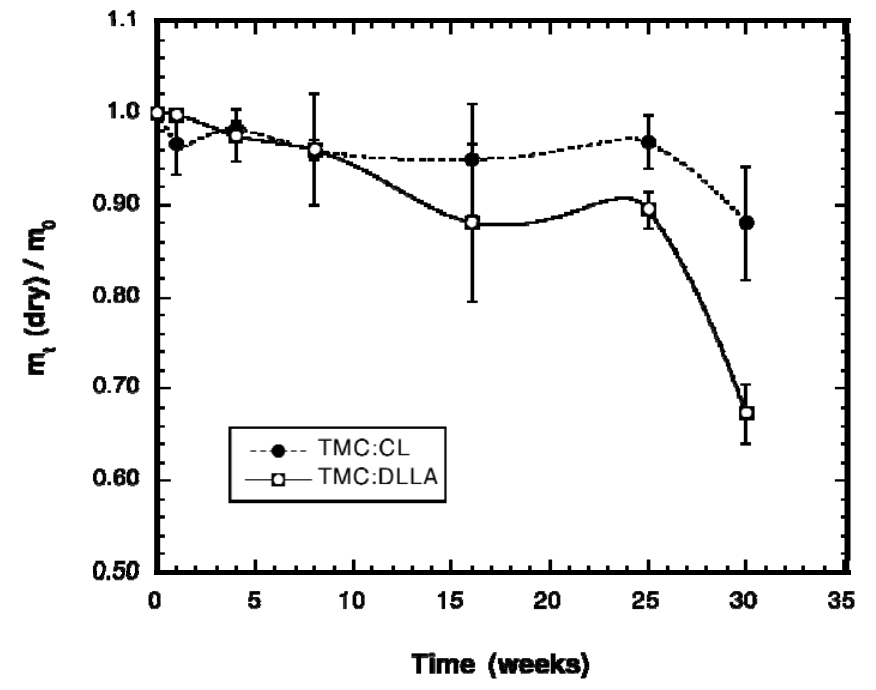
Figure 2. Change in weight during implantation time of elastomers prepared from TMC prepolymers copolymerized with either CL or DLLA. The data is expressed as the ratio